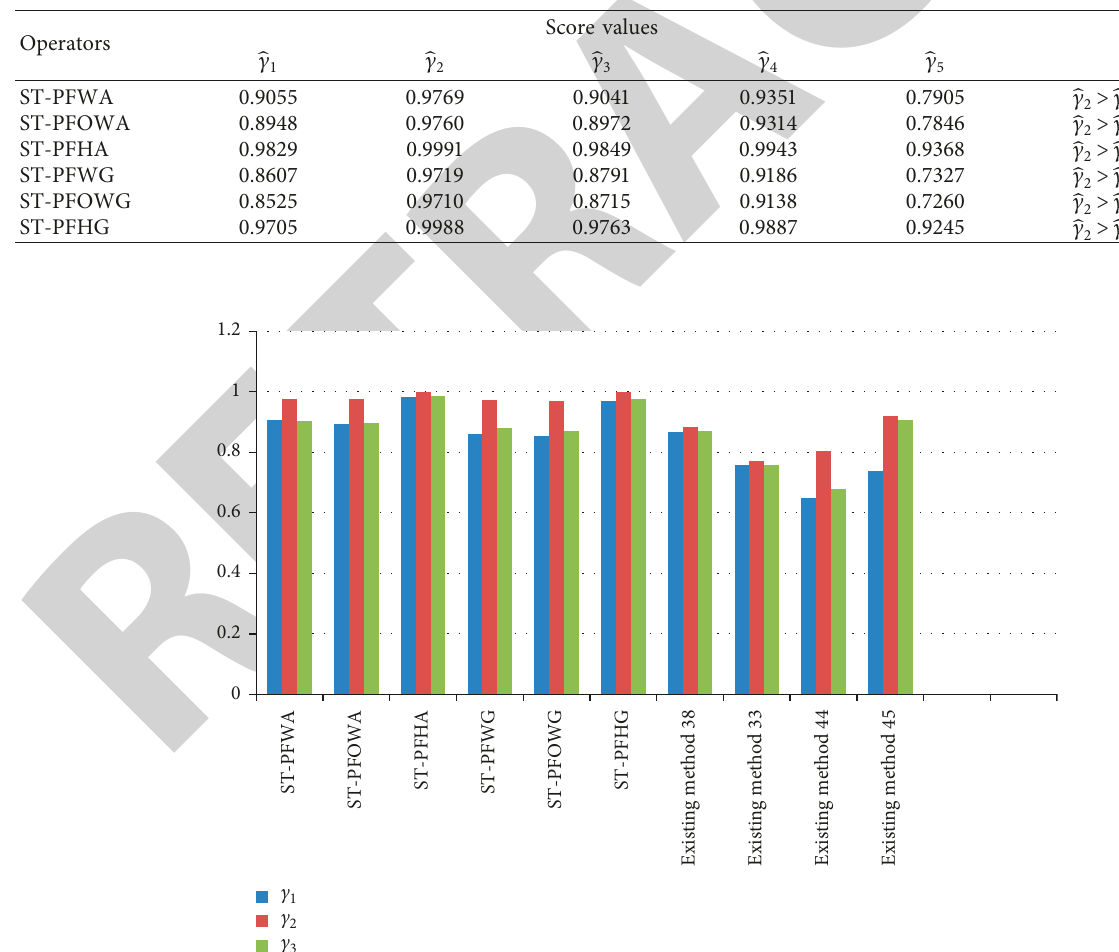
Table 5: Score value and ranking of the different operators.